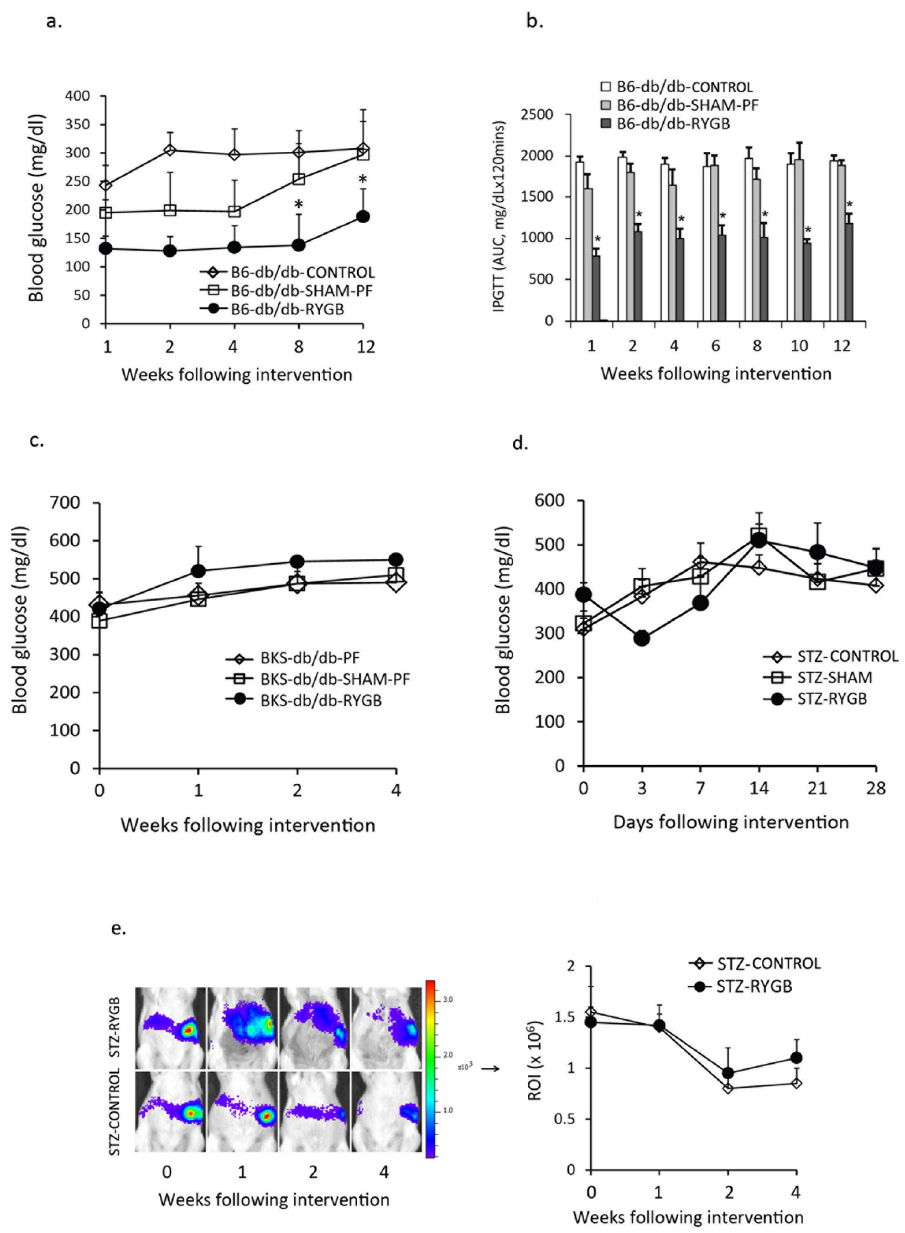
Fig 5. RYGB improves hyperglycemia in adult B6-db/db mice, but not in adult diabetic BKS-db/db mice and chemically induced diabetic mice. a. RYGB maintained normoglycemia in adult B6-db/db mice. � : B6-db/db-RYGB (n = 8) vs. B6-db/db-Control (n = 5) and B6-db/db-SHAM-PF (n = 5), p < 0.05. b. RYGB improved glucose tolerance (intraperitoneal glucose tolerance test) in adult B6-db/db mice. � : B6-db/db RYGB (n = 8) vs. B6-db/db-Control (n = 5) and B6-db/db SHAM-PF (n = 5), p < 0.01. c. RYGB failed to reverse hyperglycemia in adult diabetic BKS-db/ db (12 weeks old) mice. BKS-PF, adult BKS-db/db mice with pair-feeding; BKS-SHAM-PF, adult BKS-db/db mice with sham surgery and pair-feeding, and BKS-RYGB, BKS-db/db mice with RYGB (n = 4 in each group). d. RYGB failed to reverse hyperglycemia in streptozotocin (STZ)-induced diabetic MIP-luc mice. STZ-Control, untreated STZ- induced diabetic mice (n = 5); STZ-SHAM, STZ-induced diabetic mice with sham surgery (n = 5), and STZ-RYGB, STZ-induced diabetic mice with RYGB (n = 6). e. Bioluminescence imaging (BLI) in STZ-induced diabetic MIP-luc mice. BLI was performed in MIP-luc mice one day before RYGB and at 1, 2 and 4 weeks after surgery. Luciferase is expressed as the regions of interest (ROI). STZ-Control, untreated STZ-induced diabetic mice (n = 6); and STZ-RYGB, STZ-indued diabetic mice with RYGB (n =